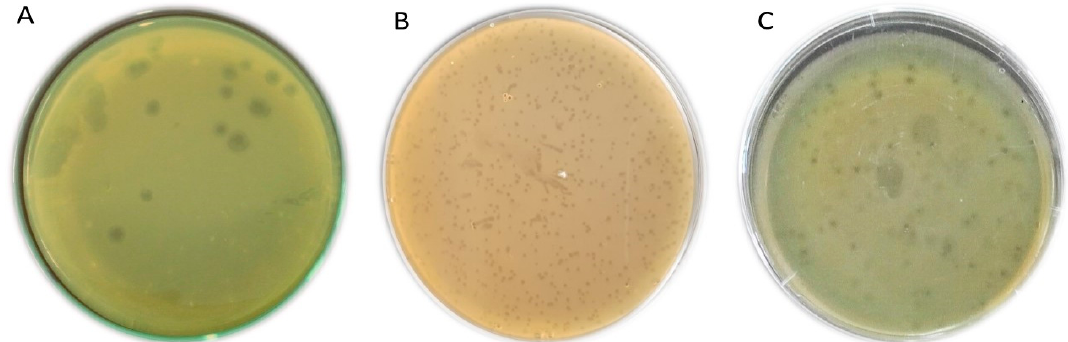
Figure 2. Plaques of di ff erent CoNS Bacteriophages. ( A ) CoNShP-3, ( B ) CoNSsP-1, and ( C ) CoNSeP-2.